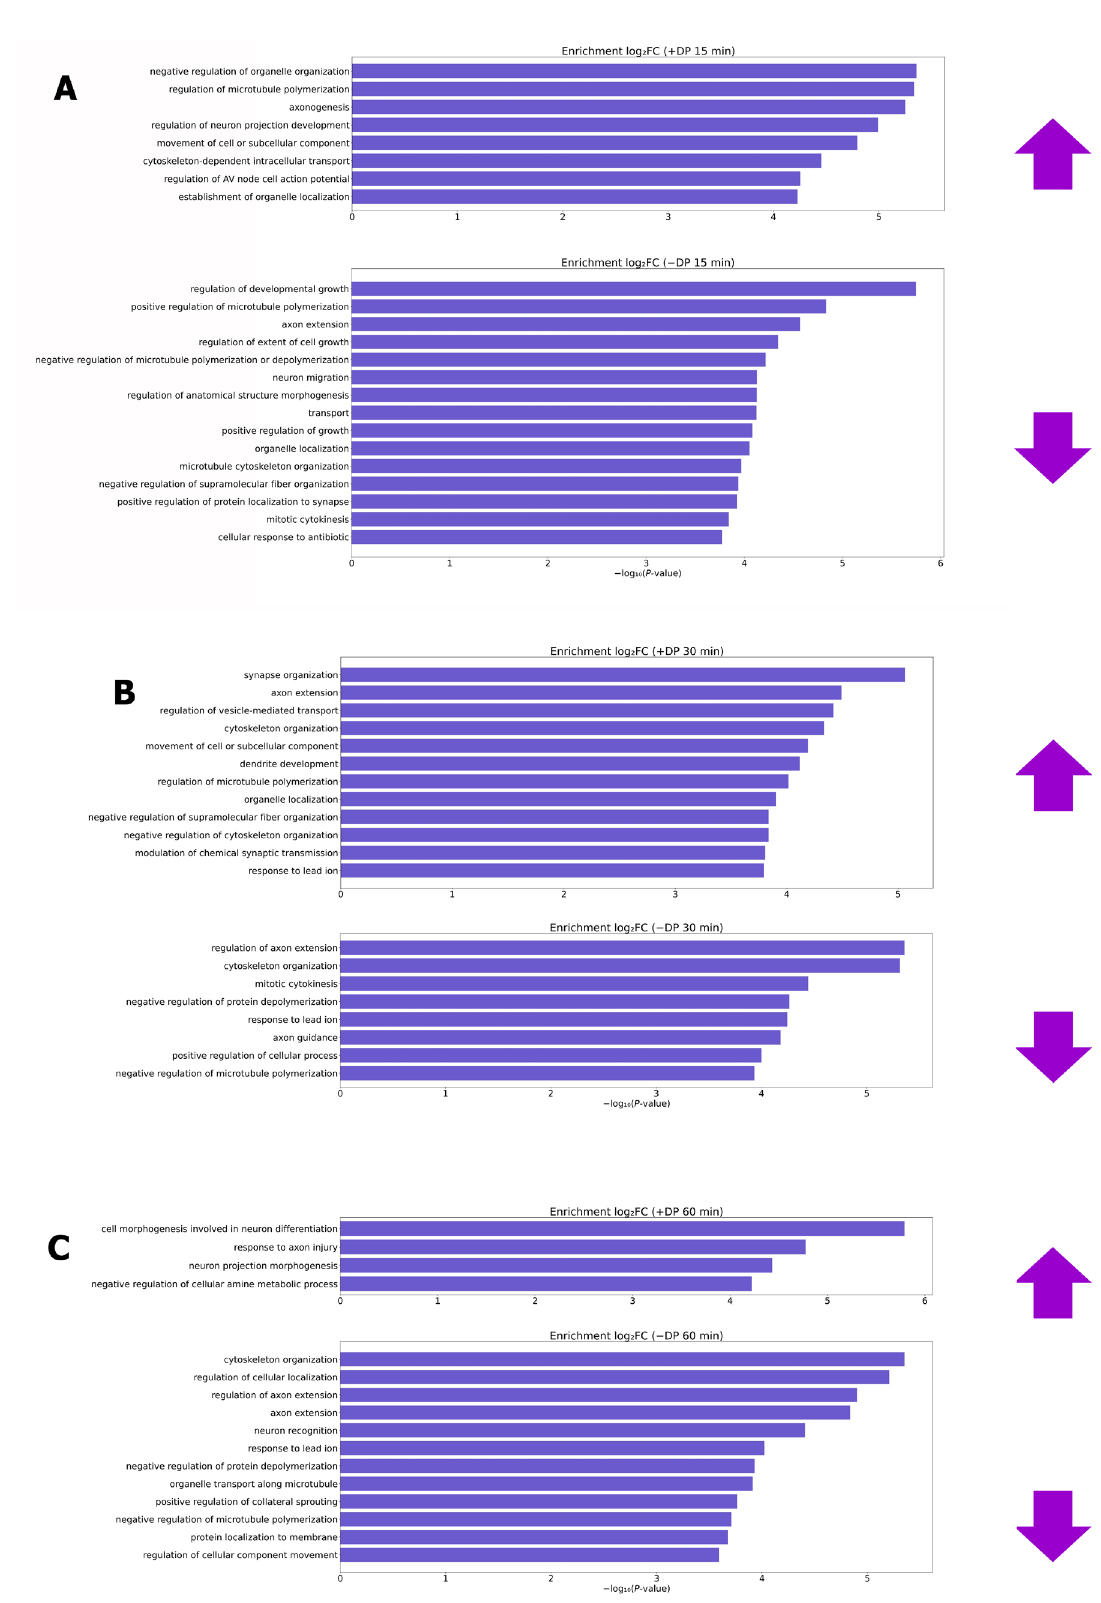
Figure 3. Biological processes enriched by differentially DP after glutamate treatment for 15 (A), 30 (B) and 60 min (C). Prefixes (+) and (–) are representatives of proteins that have obtained normalized fold change by the transformation of log (increasing and decreasing phosphorylation levels, respectively). log 2